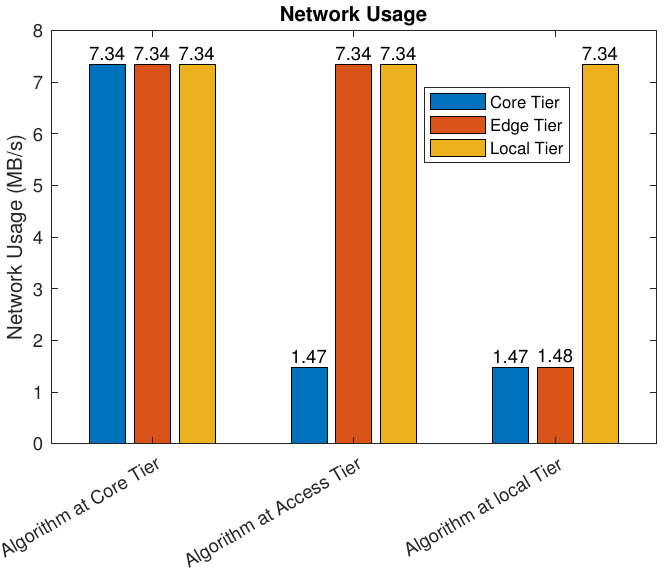
Figure 9. Network usage: with the blockchain. When the data were analyzed at the core tier (data center), the network utilization in each of the three tiers was 7.34 MB/s. In this scenario, all data, including control and raw data, were delivered through the whole data path between the IoT nodes and